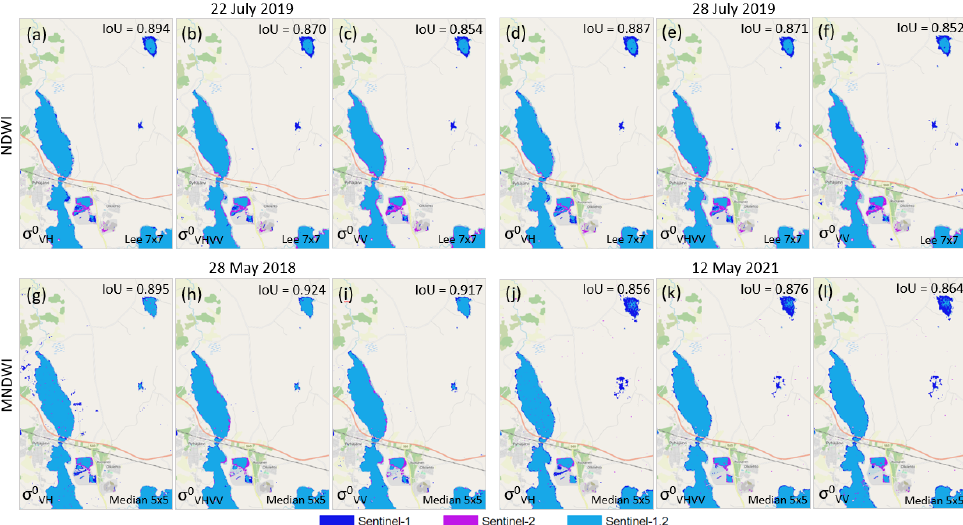
Figure 16. Maps of surface water bodies based on SAR data σ 0 the largest IoU discrepancies of water masks based on σ 0 7 × 7, σ 0 ; ( b ) 22 July 2019, NDWI , Lee 7 × 7, σ 0 VH